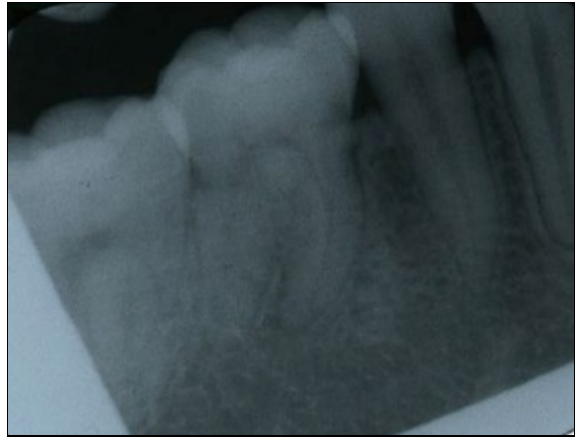
Figure 11. One year post-surgical radiograph.